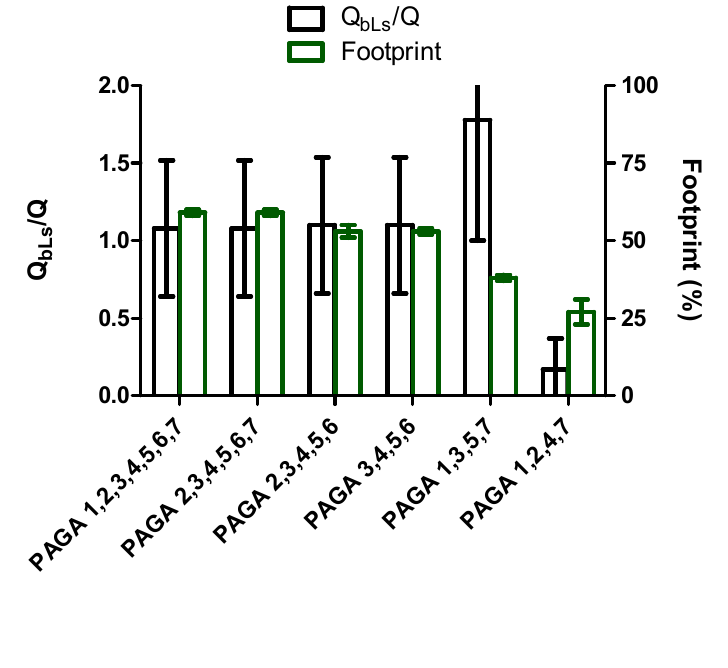
Figure 9. Accuracy of measured emission Q combinations of horizontal point concentration